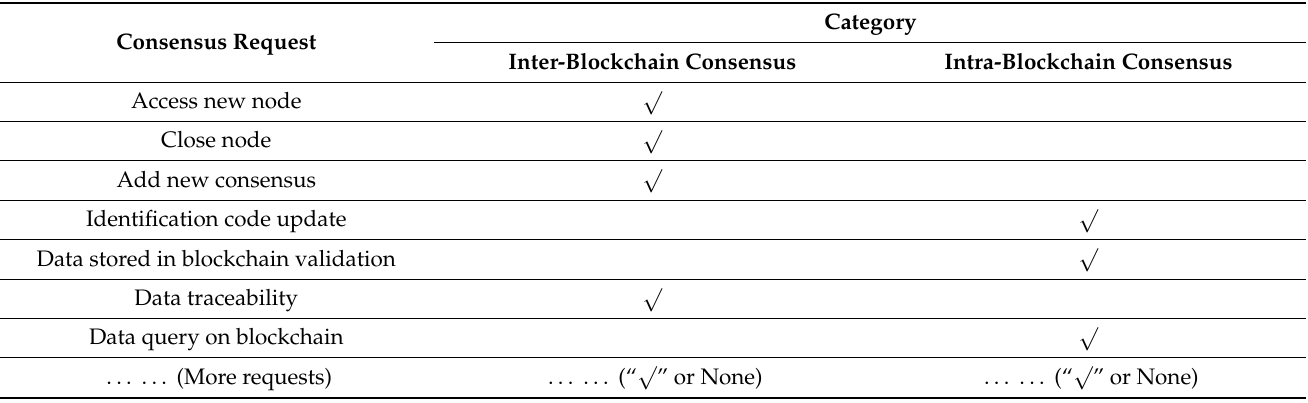
Table 2. Consensus request classification